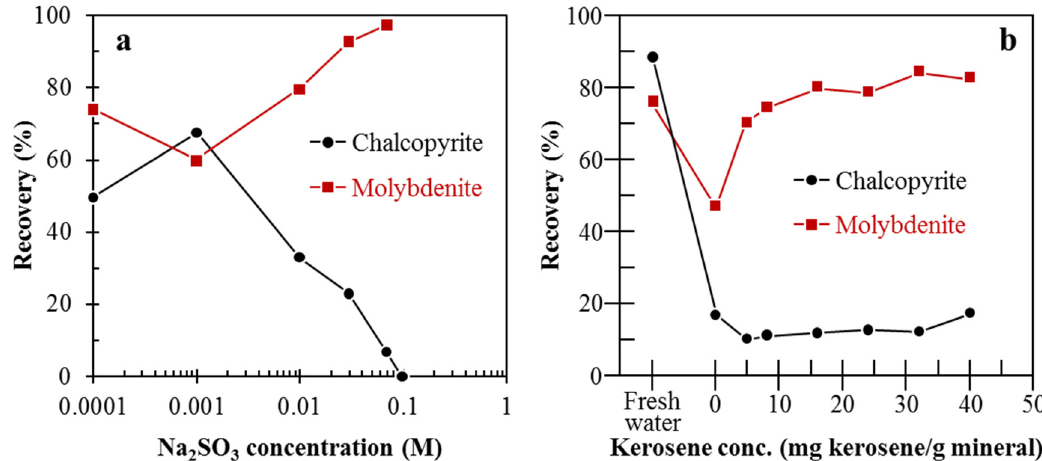
Figure 8. Recovery of chalcopyrite and molybdenite with varying concentrations of ( a ) Na 2 SO 3 in TMD solution (mixture of TX15216 (alkyl mercaptan), MX-7017 (modified thionocarbamate), and diesel oil) [43] and ( b ) kerosene in MgCl 2 solution (reprinted with permission from Hirajima et al. [54], copyright (2016) Elsevier).